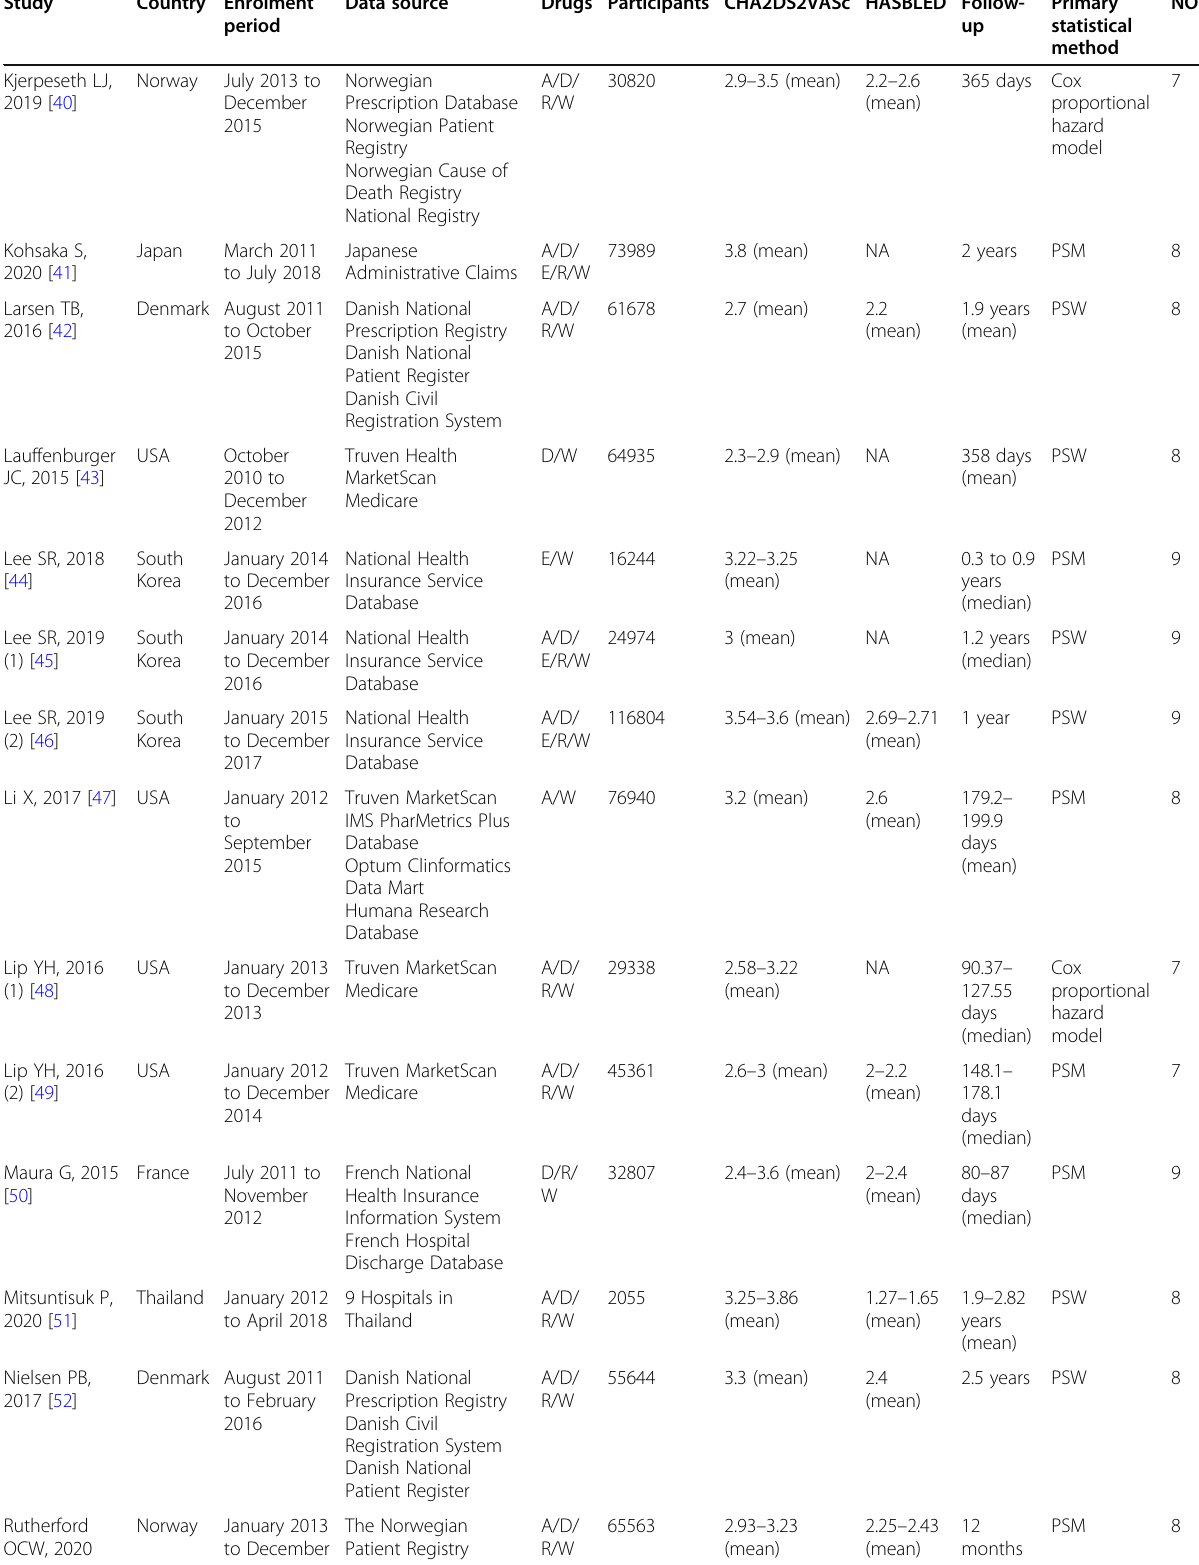
Table 1 Baseline characteristics of the studies